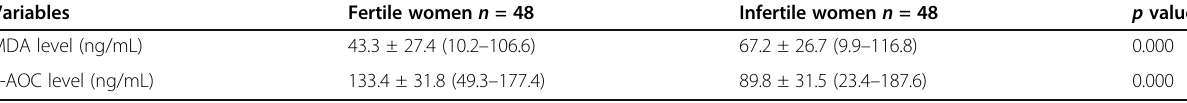
Table 4 MDA and T-AOC values of fertile and infertile women attending MNH, Dar es Salaam, Tanzania